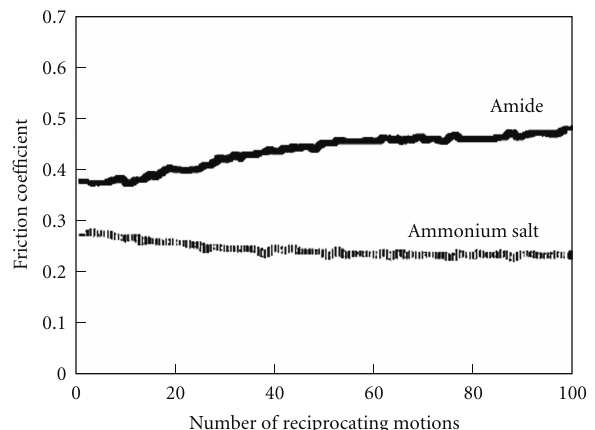
Figure 9: Comparison of frictional properties of ammonium carboxylate ionic liquid and the corresponding amide during a friction test with 40 atomic % fluorine.